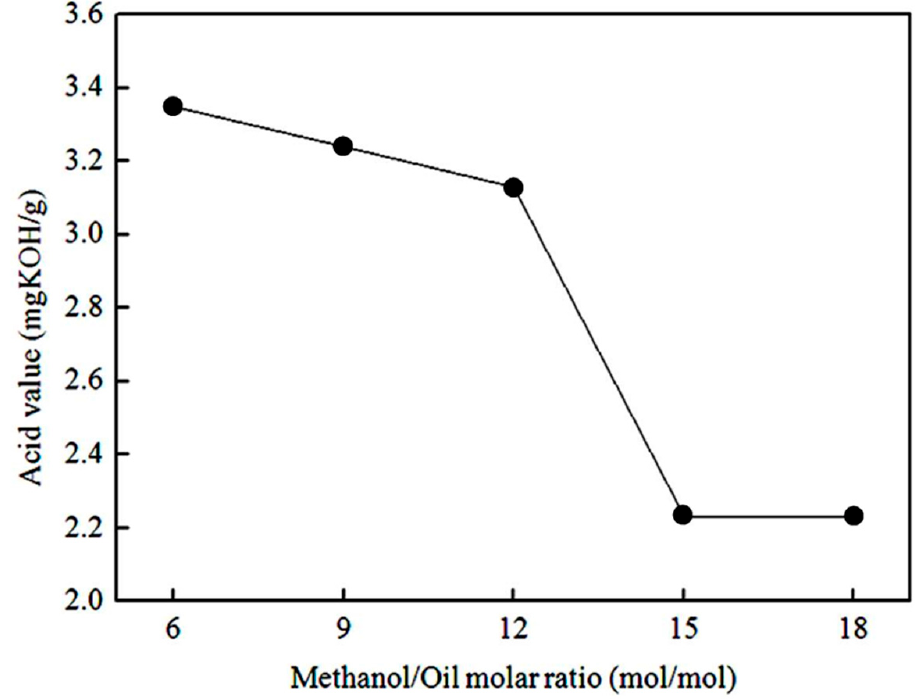
Figure 2. Effect of methanol/oil molar ratio on the acid value.